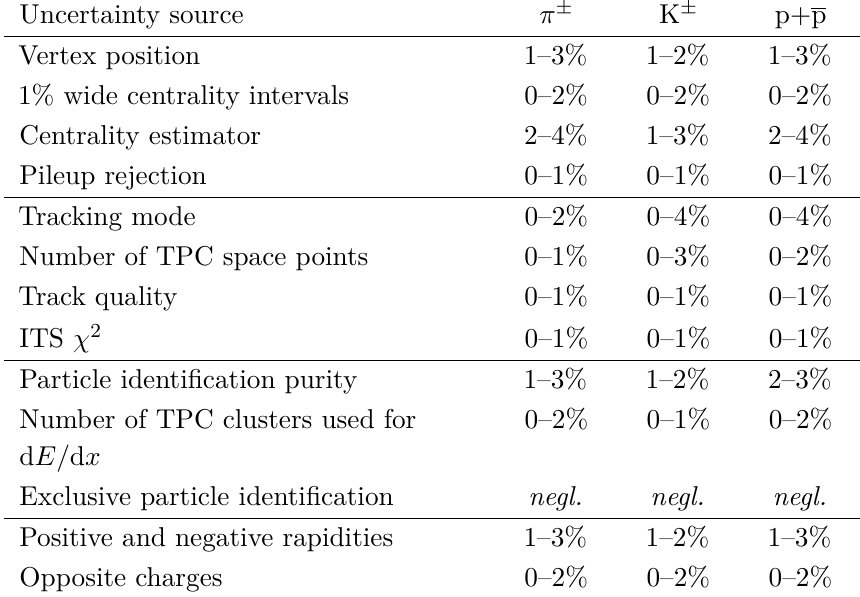
Table 2. Summary of systematic uncertainties for the v 3 of π ± , K ± , and p+ p . Uncertainties are given as intervals between the minimum and maximum values for all p T and centrality ranges. The field marked negl. for negligible implies that the tested uncertainty cannot be resolved within the statistical